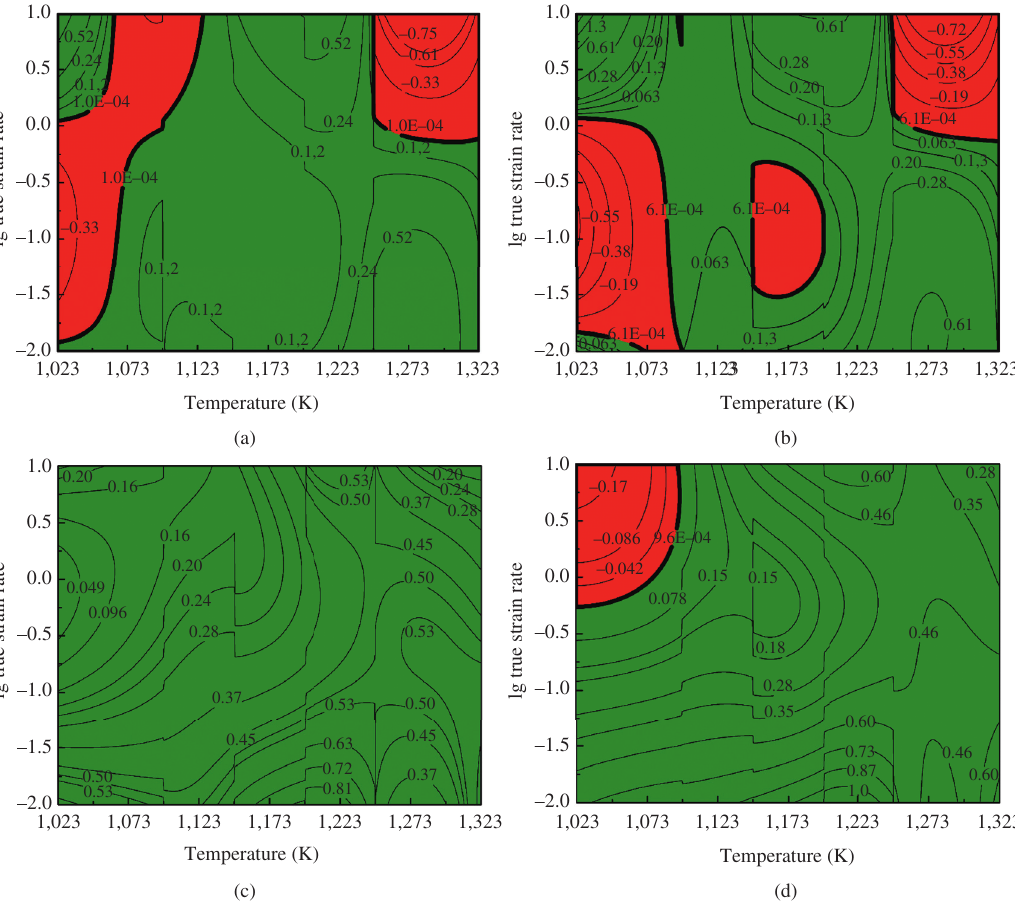
Figure 8 : Instability maps as the true strain: (a) " ¼ 0 : 3 , (b) " ¼ 0 : 5 , (c) " ¼ 0 : 7 , (d) " ¼ 0 : 9 , representing different regions of stable and unstable flow in the frame of strain rate and